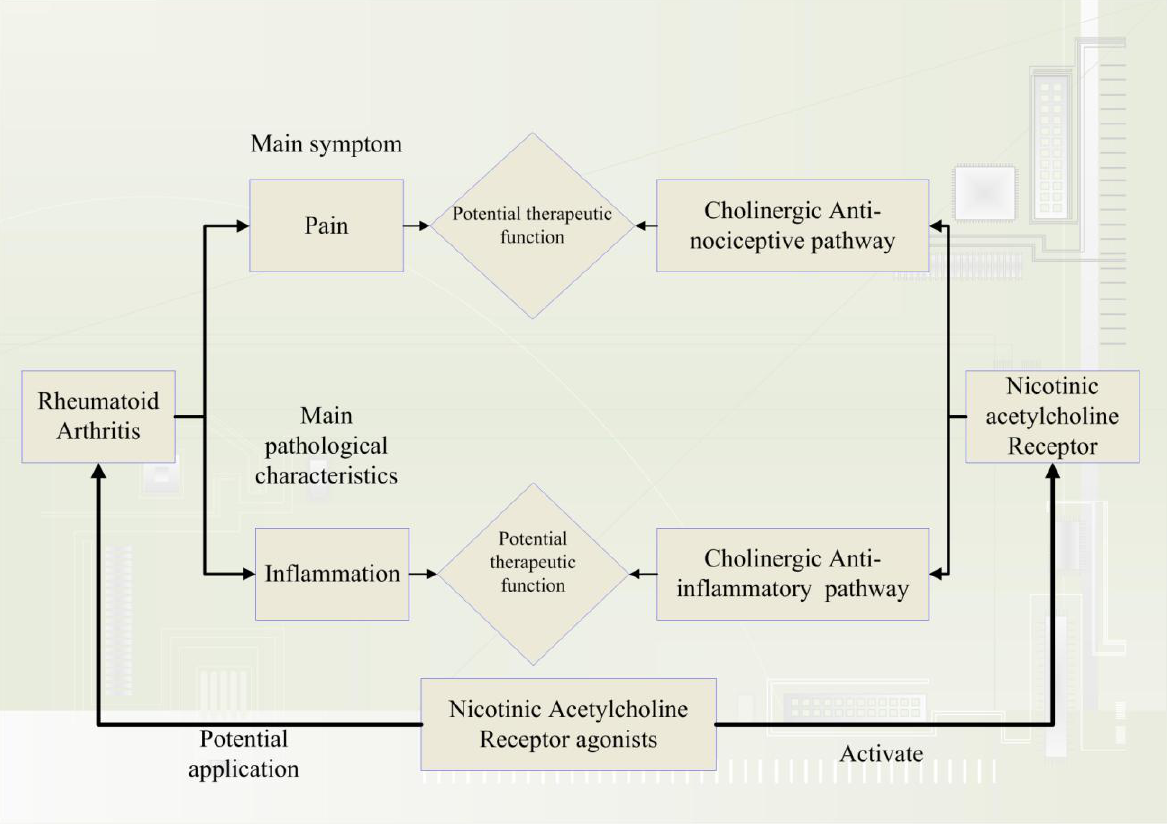
FIGURE 1 . The diagrammatic illustration of the potential application of cholinergic anti-inflammatory and antinociceptive